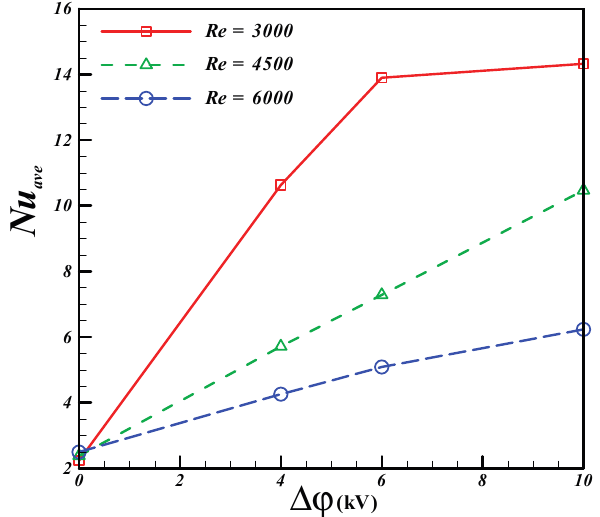
Figure 8. Effects of Reynolds number and supplied voltage on average Nusselt